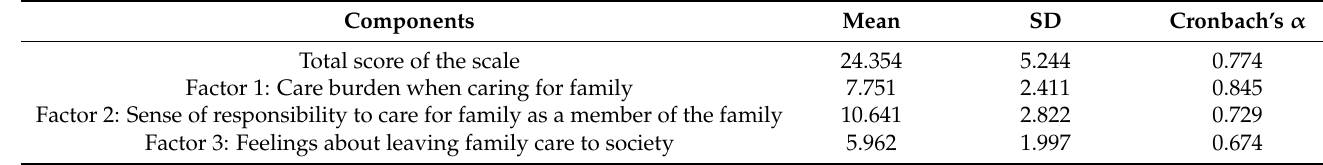
Table 3. Reliability of the awareness of long-term care socialization.